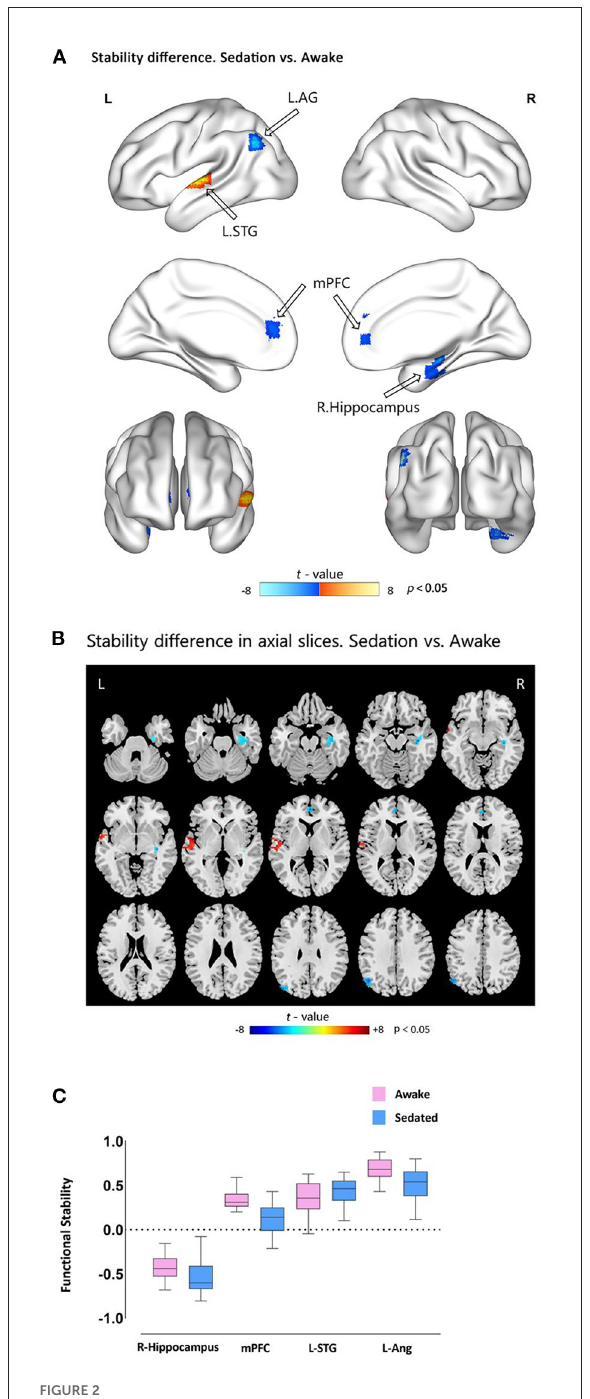
FIGURE2 Functional stability differences between awake and dexmedetomidine sedation states. (A) Brain maps of t -values showing the results of paired-sample t -tests comparing functional stability during sedation vs. awake states. Cold-color clusters represent brain regions with lower stability during sedation than during the awake state (indicated by hollow arrows), and vice versa. (B) The axial slices view of the above mentioned t -test results. (C) Box plots showing the functional stability differences in the significant clusters between the two states. mPFC, medial prefrontal cortex; AG, angular gyrus; STG, superior temporal gyrus.